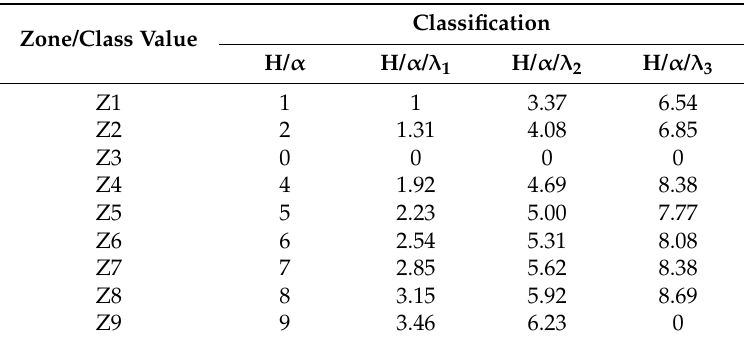
Table 2. Class values of segmented zones for the H/ α , H/ α / λ 1 , H/ α / λ 2 , and H/ α / λ 3 classifications using the H/ α segmentation plane for random media scattering.